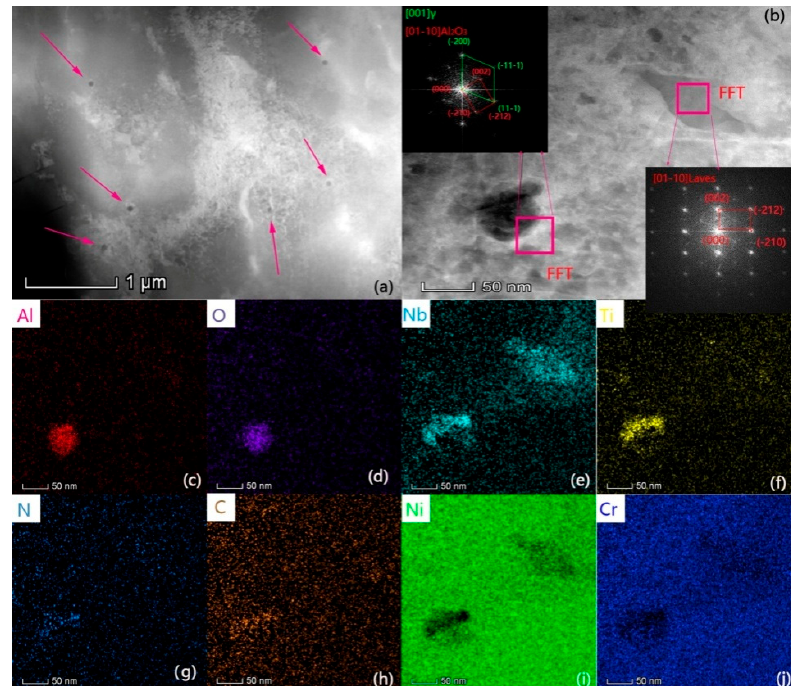
Figure 7. ( a ) the bright field image of the nanoparticles; ( b ) high-resolution transmission electron microscopy (HRTEM) image of one of the nanoparticles, embedded images are the fast Fourier transform (FFT) of boxed areas, respectively; ( c – j ) the element content distribution on this visual field.